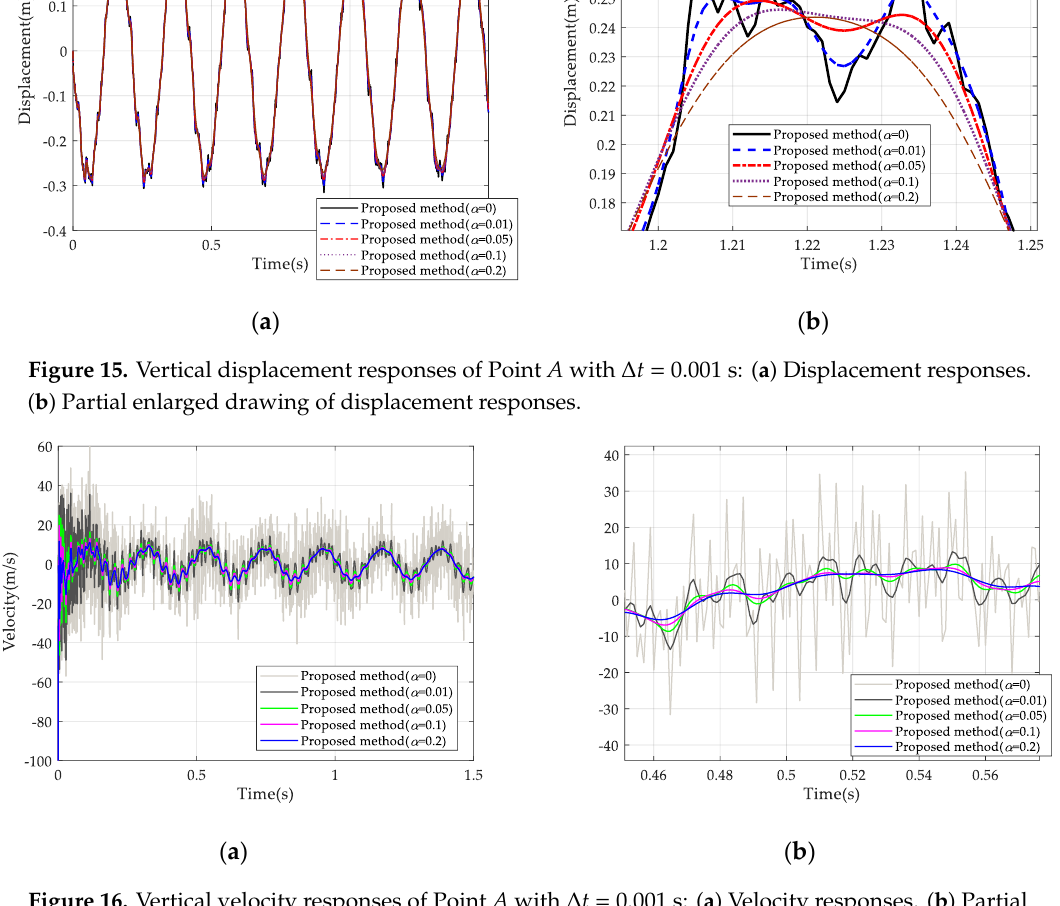
Figure 16. Vertical velocity responses of Point A with ∆ t = 0.001 s: ( a ) Velocity responses. ( b ) Partial enlarged drawing of velocity responses.